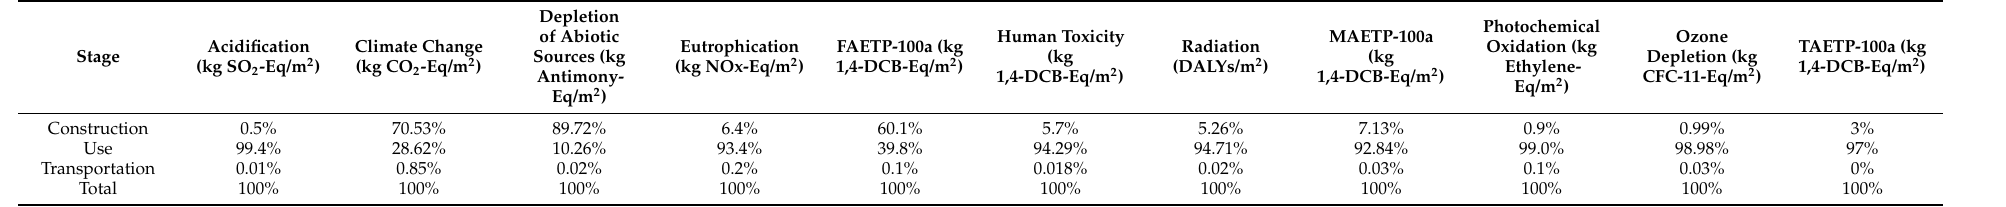
Table 6. Percentage contribution of life cycle stages to environmental impact of SC3 (ventilation systems are